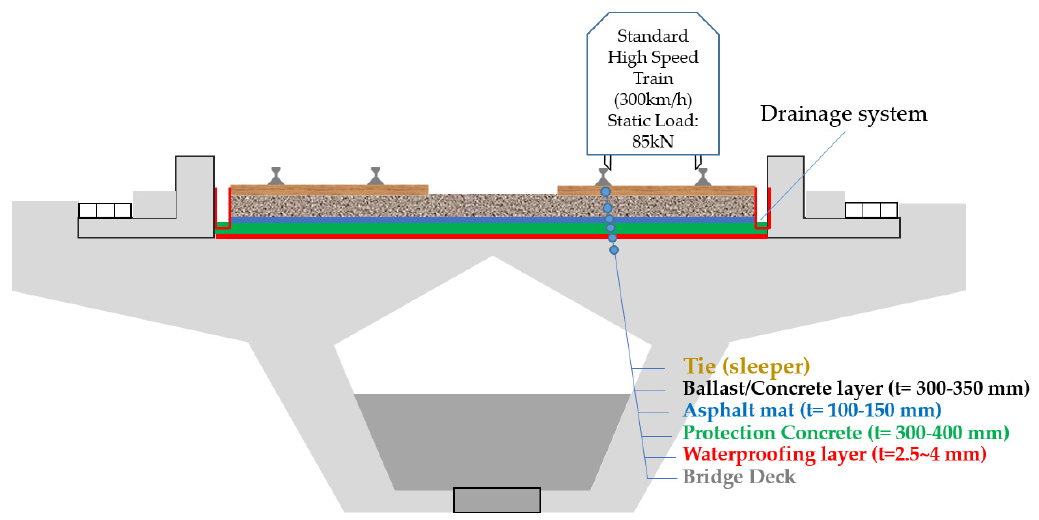
Figure 2. Sample pre-stressed concrete (PSC) track bed structure design layout with waterproofing system.